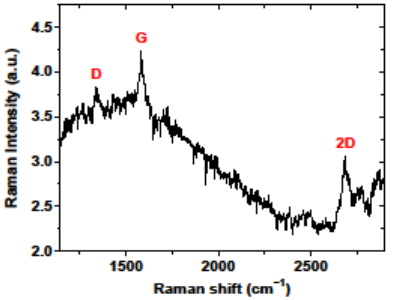
Figure 4. Raman spectrum of few − layer graphene on the copper substrate.